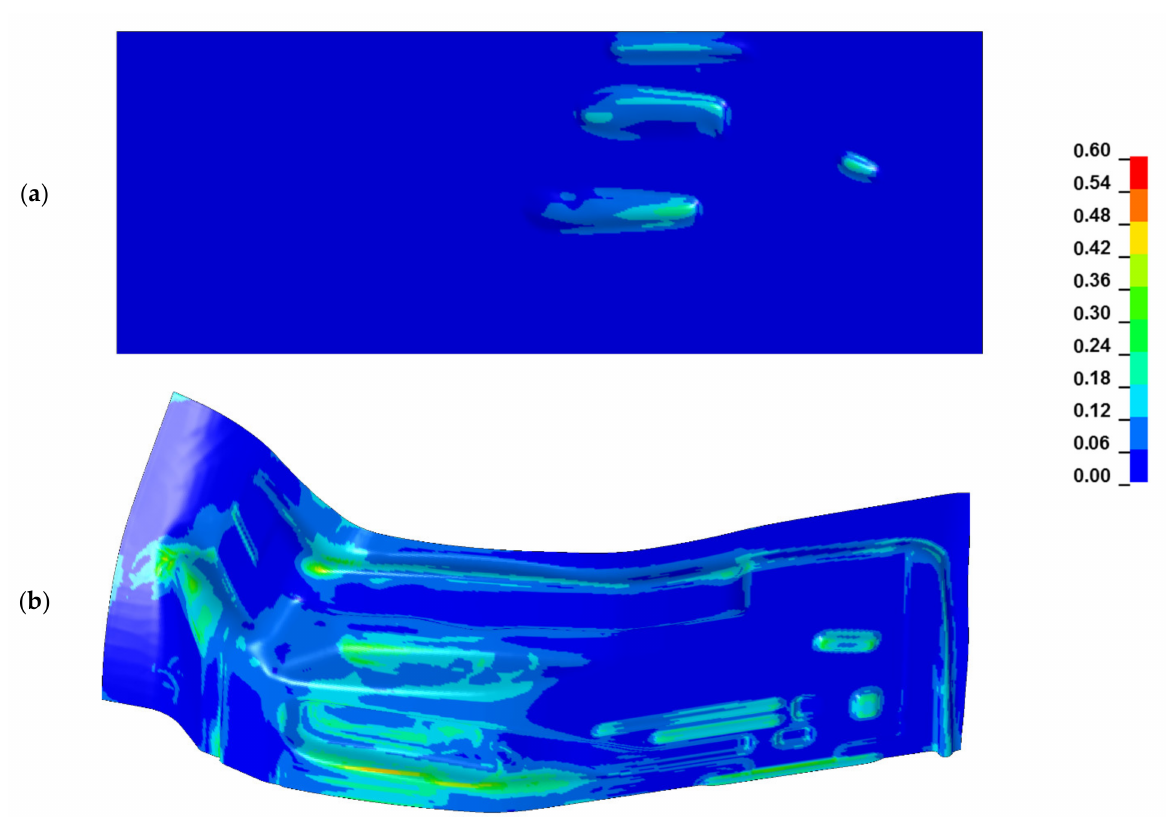
Figure 13. Simulation of two-step forming process: ( a ) preforming step, maximum strain is 0.213; ( b ) fully formed part, maximum strain is